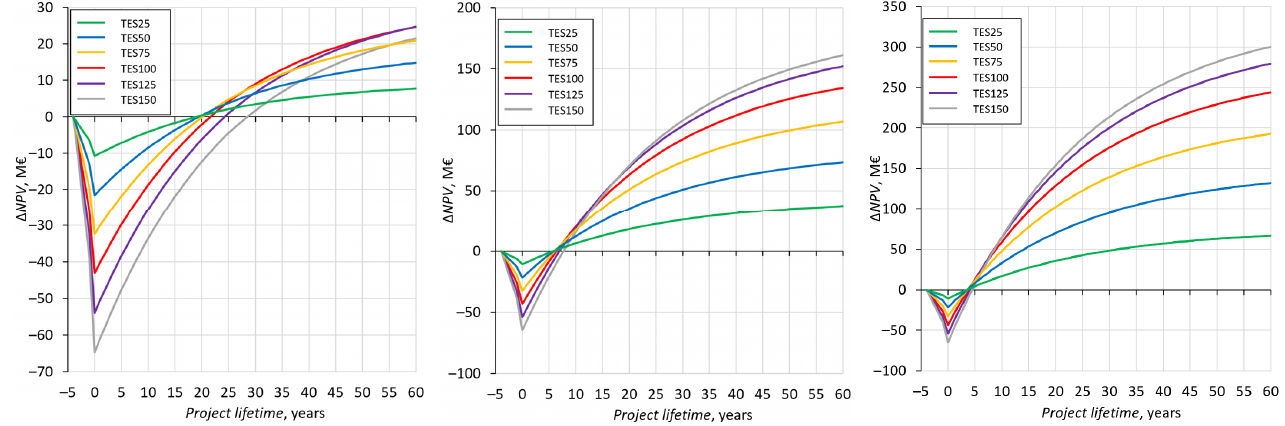
Figure 15. ∆ NPV as a function of project lifetime for the three values of deviation index (left = − 0.2/0.2, central = − 0.5/0.5, and right = − 0.8/0.8).